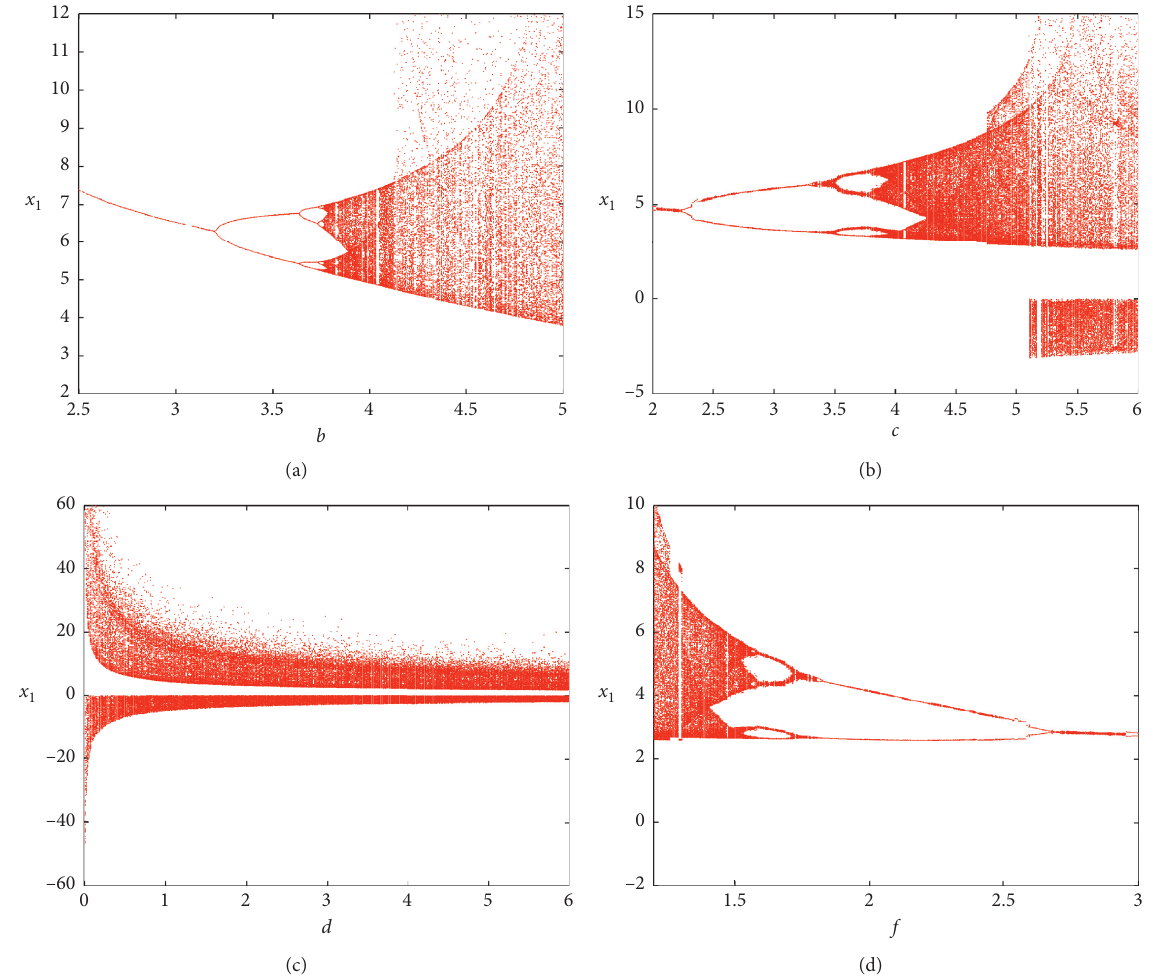
Figure 12: Modulation property of signal amplitude for system